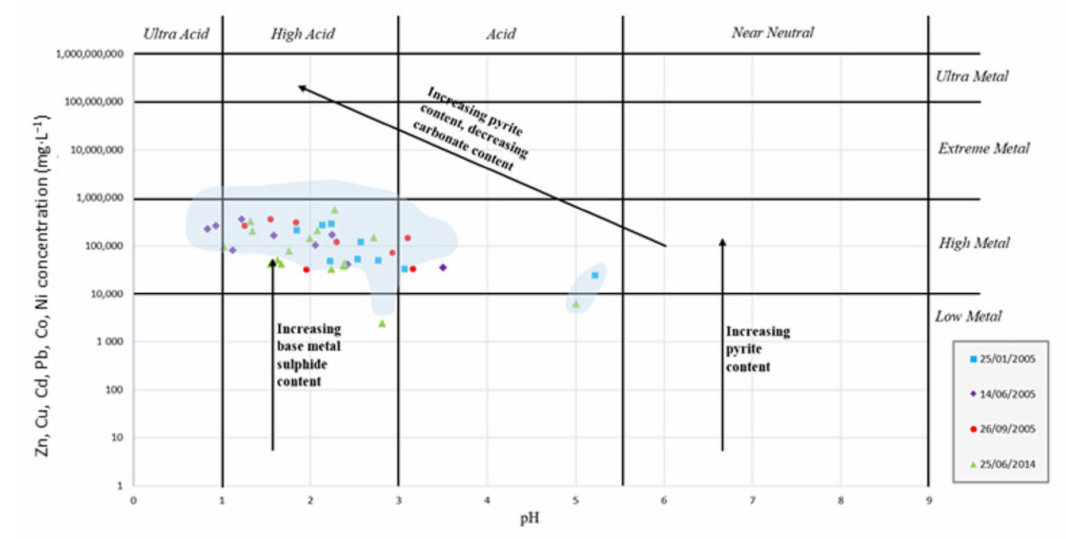
Figure 15. Characterization of the Rio Tinto waters as high acid and high metal, according to the Ficklin diagram.